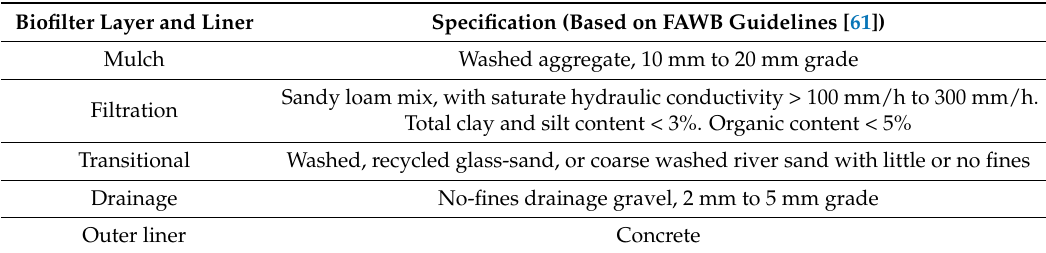
Table 3. City of Sydney specifications for biofilter material (fill).